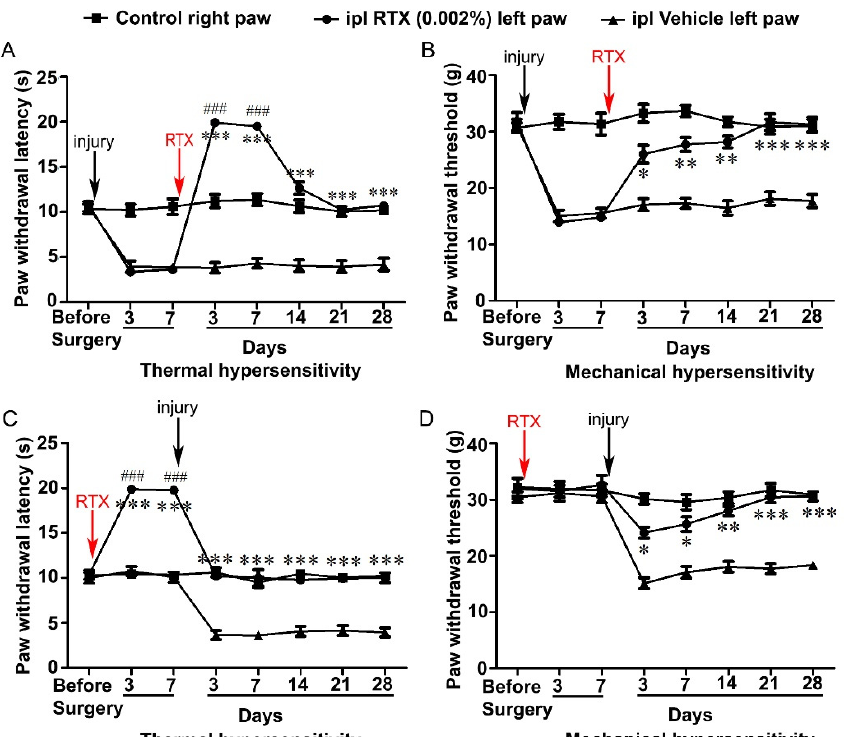
Figure 2. Analgesic effects of the intraplantar injection of RTX (0.002%) for the treatment ( A , B ) and prevention ( C , D ) of thermal and mechanical hypersensitivity induced by L5 nerve injury. RTX treatment after 3 and 7 days abolished L5 injury-induced thermal hypersensitivity and produced analgesic effects as the left foot became less sensitive to heat stimuli compared with right control foot ( A ). Interestingly, after 2–4 weeks, RTX-injected rats showed significantly increased thermal paw withdrawal latency compared to vehicle-injected rats but not with the right control paw latency ( A ). The mechanical hypersensitivity in RTX-injected animals was significantly reduced after 3–7 days compared with vehicle-injected rats, and the mechanical paw withdrawal latency returned to the basal level after 14 days compared with right control paw latency ( B ). Pretreatment of RTX showed a significant increase in the thermal paw withdrawal latency after 3 and 7 days compared to right control paw latency ( C ). In contrast, no significant difference was observed in mechanical paw withdrawal latency following RTX treatment ( D ). After 7 days of RTX treatment, the L5 nerve was injured to induce neuropathic manifestations. The results showed a significant increase in thermal and mechanical paw withdrawal latency in RTX-injected rats compared to vehicle-injected rats, but no significant difference was observed between left RTX-injected and right control paw withdrawal latencies [C–D]. [(*RTX vs . vehicle; #RTX vs. right control) * p < 0.05; ** p < 0.01; *** p < 0.001, ### p < 0.001; n = 7 each group].